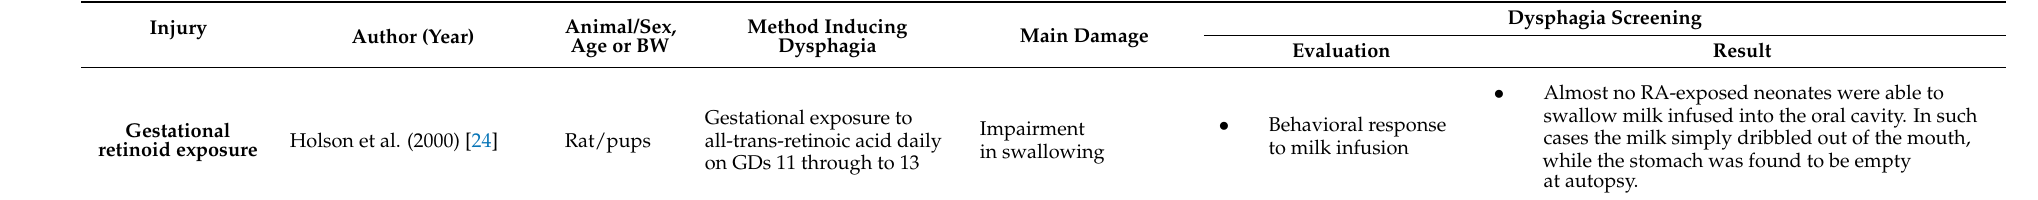
Table 4. Characterization of oropharyngeal dysphagia in rodent model of other